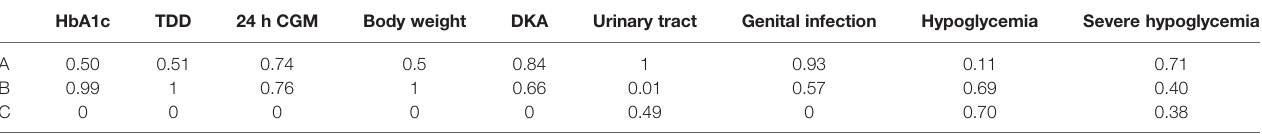
TABLE 1 | SUCRA values of different interventions and outcomes were analyzed.